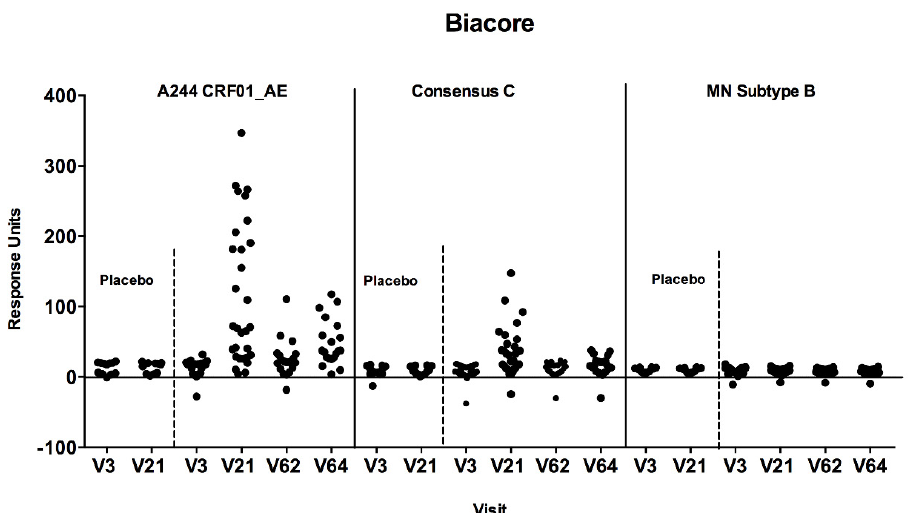
Figure 4. Antibody responses to cyclic V2 loop peptides by SPR/Biacore assay. Plasma samples were tested against A244 CRF01_AE, Consensus C and MN subtype B at baseline (V3) four weeks after